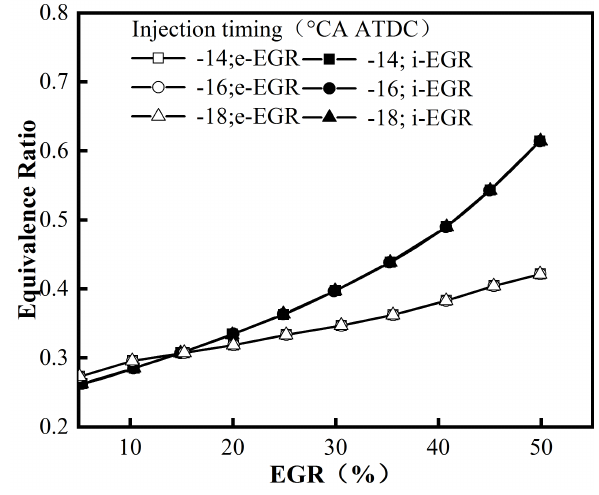
Fig. 5 Effects of i-EGR and e-EGR ratios on equivalence